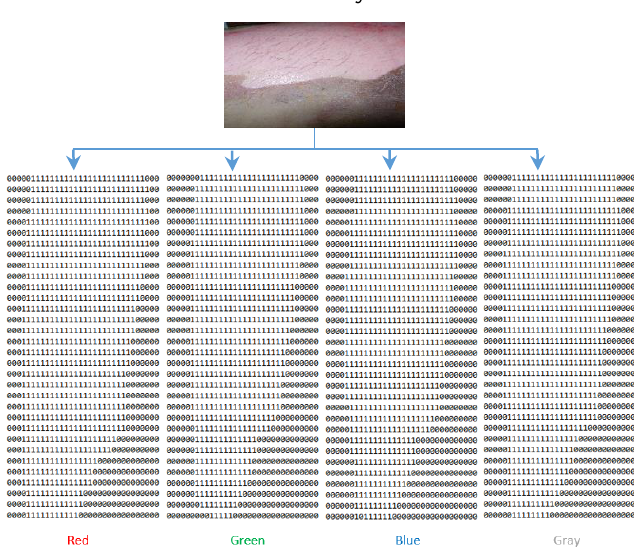
Fig. 12. Multi color channels extraction